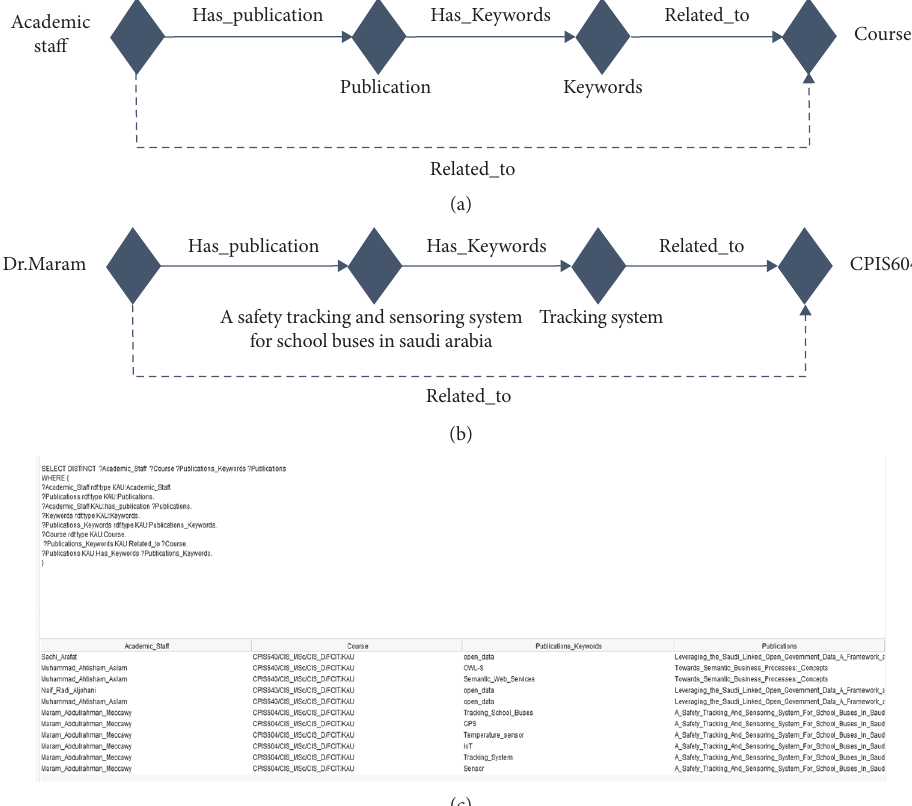
Figure 7: The visualization of Related_to property with publications and the results of the